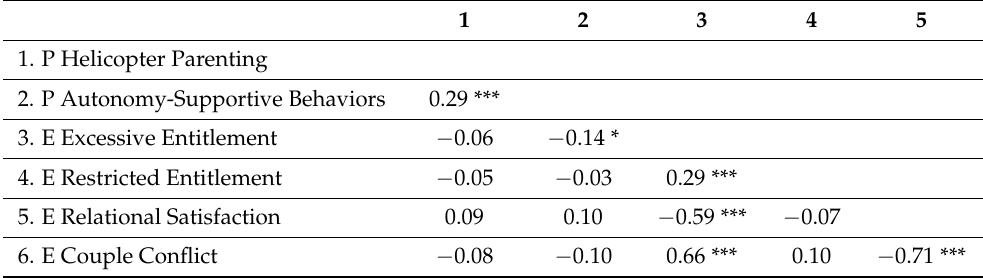
Table 2. Correlation